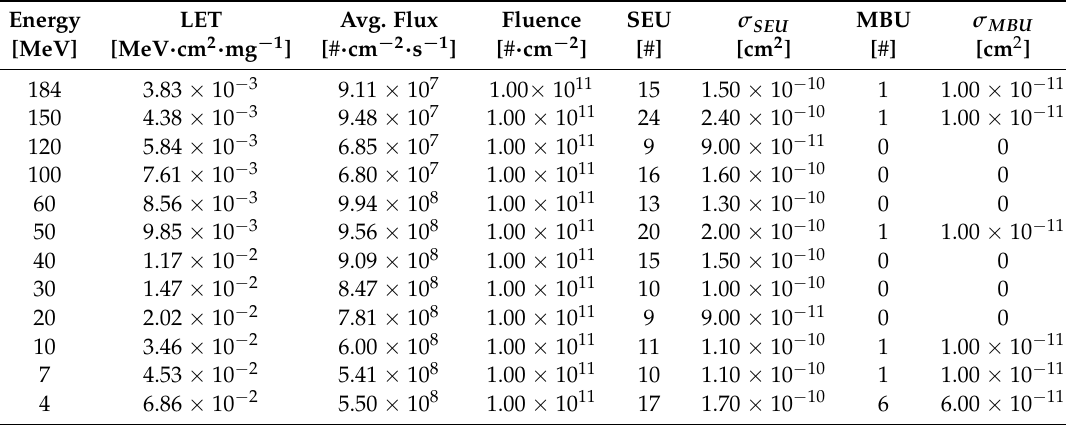
Table 4. SEU and MBU rate for DUT Sample